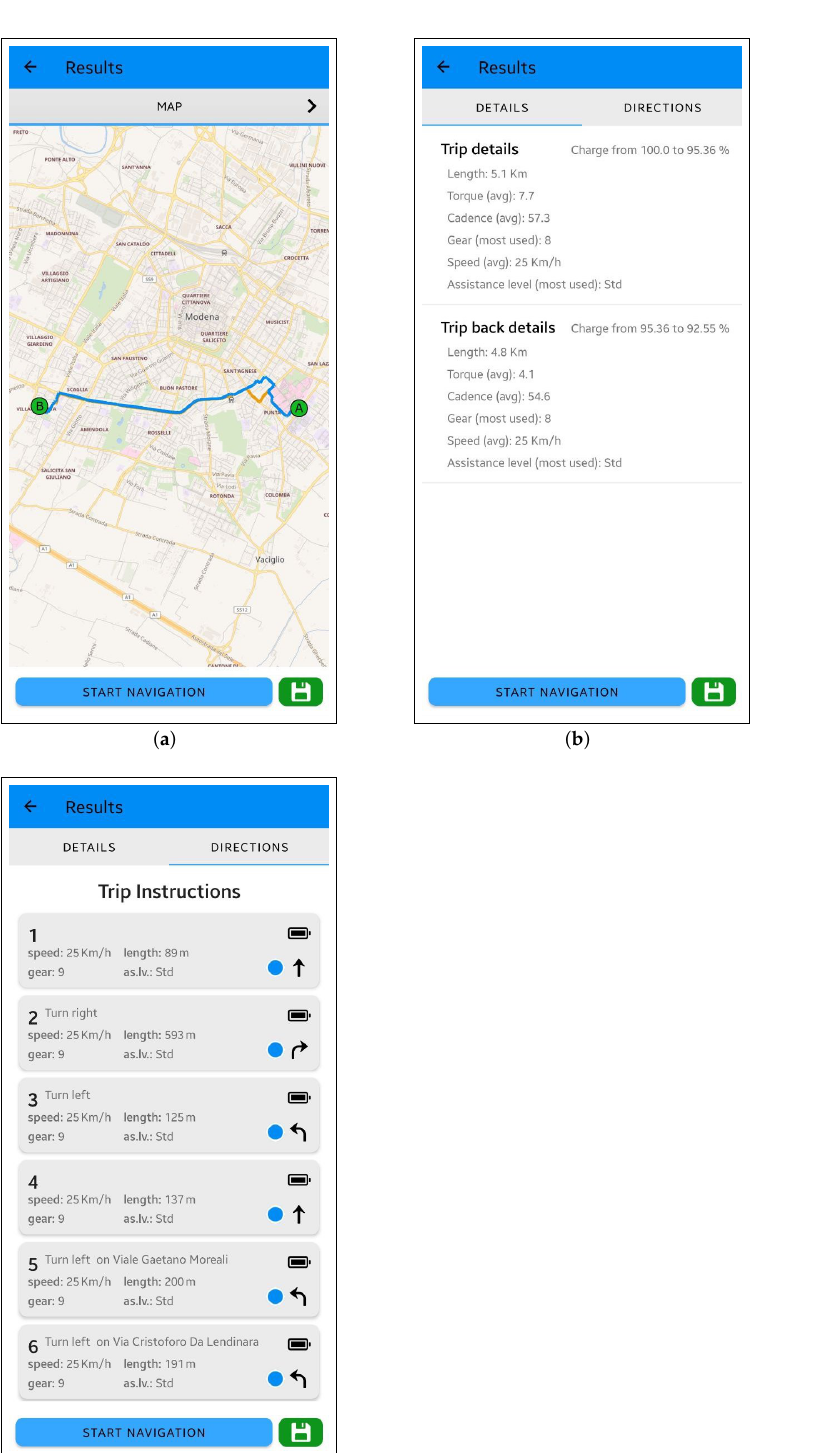
Figure 3. Result pages. ( a ) The results page to that shows the interactive map. ( b ) The results page to that shows the average results calculated. ( c ) The results page to that shows the instructions to follow the defined path and all their specific previewed